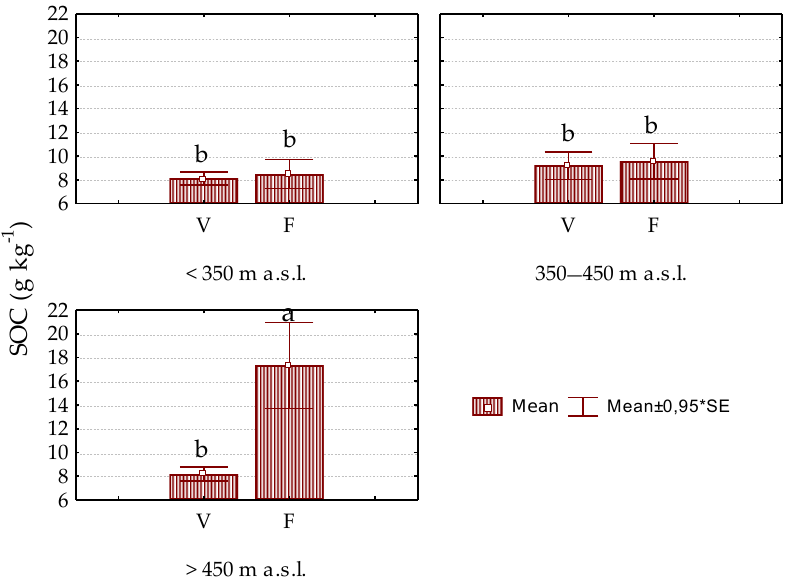
Figure 10. Effects of land use on SOC across topographic positions. Significant differences between soil groups are labeled with different letters, p < 0.05 (N = 60). V—vineyard,